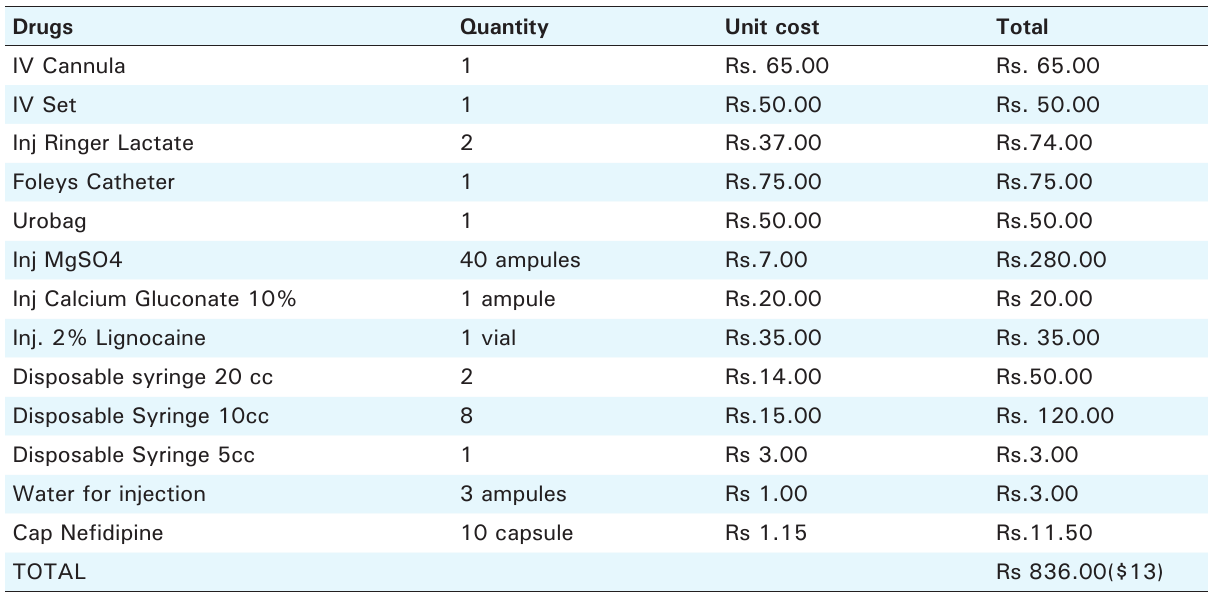
Table 7. Cost of Medicines for Eclampsia Patients